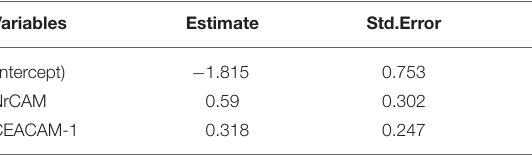
TABLE 3 | Coefficients from the logistic regression model.